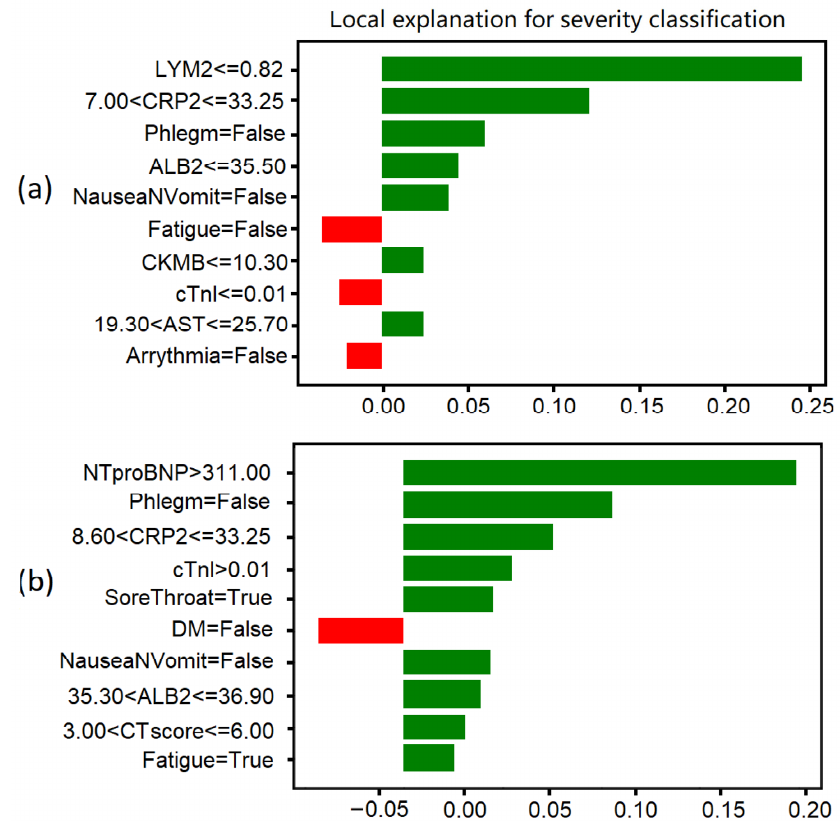
Figure 2. Comparison of clinico-radiological features in different cases based on local interpretable model-agnostic explanations (LIME). ( a ) A correctly classified severe cases in two-type classification. ( b ) A correctly classified severe case in four-type classification. The values on x axis are the coefficients of the ridge regression model fitted locally to the predictions from the original model. Features in green have a positive contribution to the prediction (increasing the probability of turning severe), and features in red have a negative effect on the prediction (decreasing the probability of turning severe).